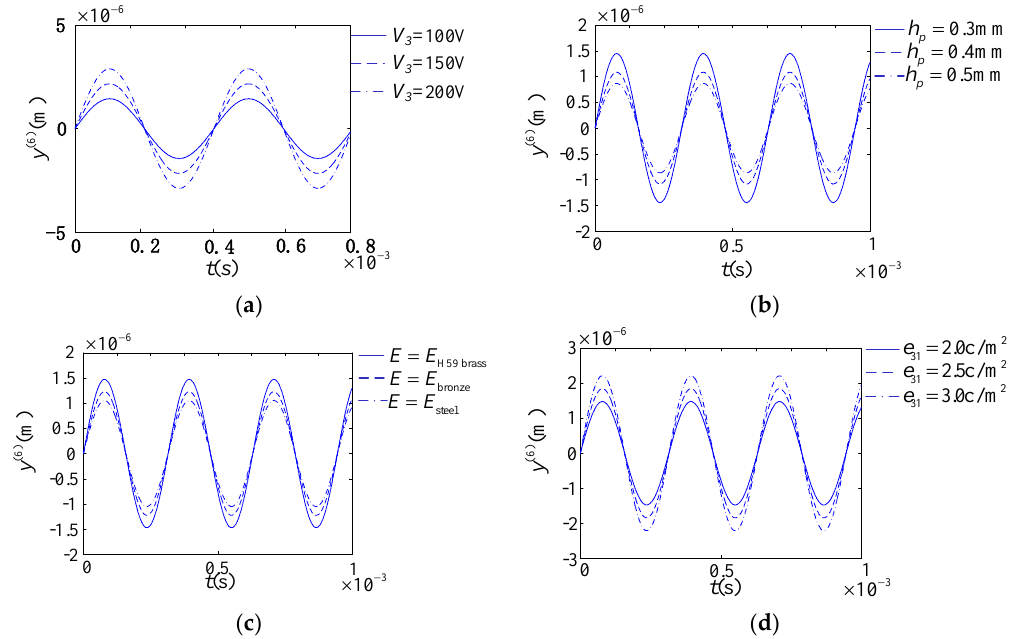
Figure 7. 6th-order forced response amplitude of the touch beam. ( a ) Forced response changes of different voltage V 3 ; ( b ) Forced response changes at different the thickness of piezoelectric sheet hp ; di ff erent voltage V 3 ; ( b ) Forced response changes at di ff erent the thickness of piezoelectric sheet hp ; ( c ) Forced response changes of different elastic modulus E ; ( d ) Forced response changes of different ( c ) Forced response changes of di ff erent elastic modulus E ; ( d ) Forced response changes of di ff erent piezoelectric constant e 31 . piezoelectric constant e 31